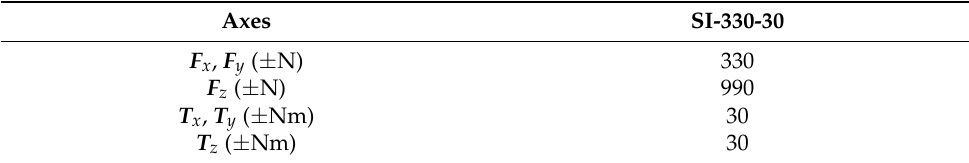
Table 4. ATI force sensor parameters.